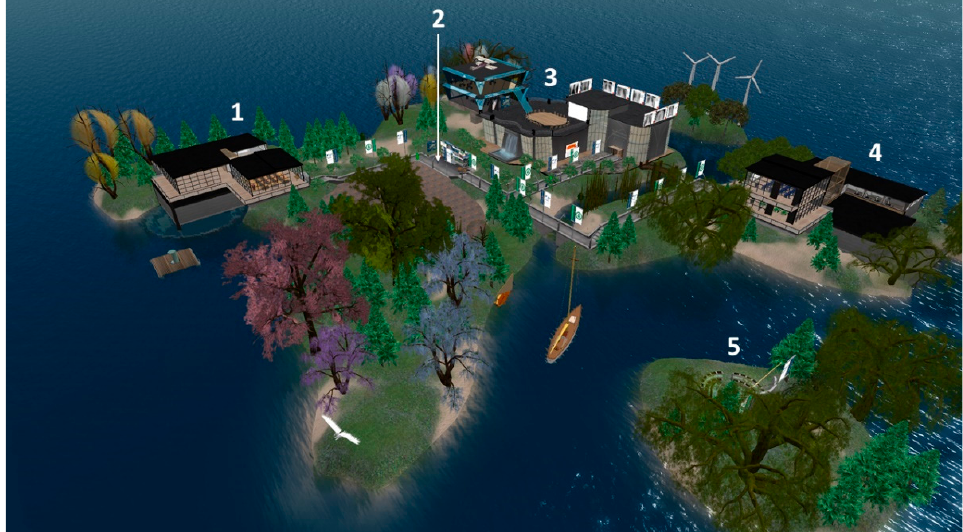
Figure 1. Aerial view of Medical Master Island: ( 1 ) Postgraduate building, where the present study was carried out; ( 2 ) point of entry to the islands; ( 3 ) Medical Master Conference Center; ( 4 ) Undergraduate building, and ( 5 ) open-air auditorium on an islet.